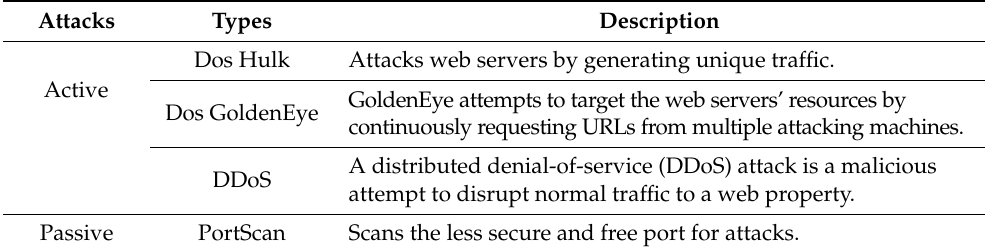
Table 1. Types of